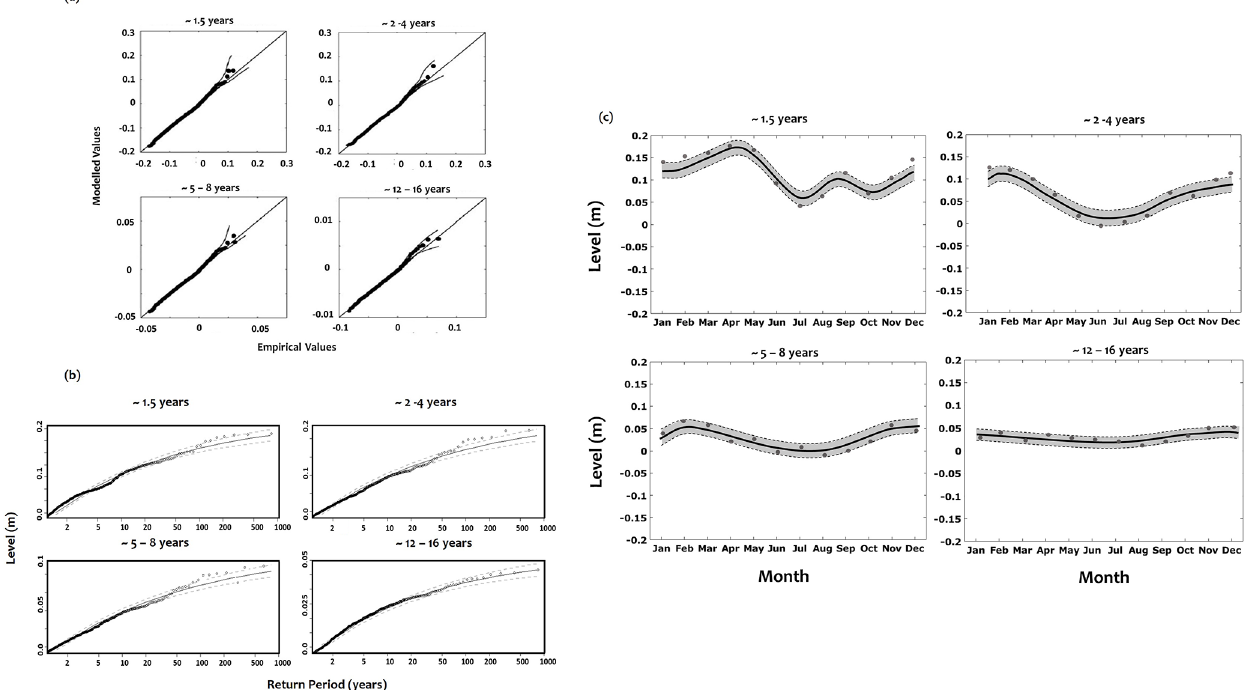
Figure 10. (a) The quantile plot between observed and modelled extreme surges by the use of the best GEV models, at different timescales, for the case of Brest. (b) The return level of extreme surges estimated for Brest using the best GEV models. The 95% confidence interval is presented with the dashed black line. (c) The 50-year return level of monthly values using the original data (grey circles) and the best nonstationary GEV model at Brest (solid black line). The lower and the upper limits of the 95% confidence interval calculated using the Bayesian method (dashed black line). The associated confidence area is represented by the grey shaded